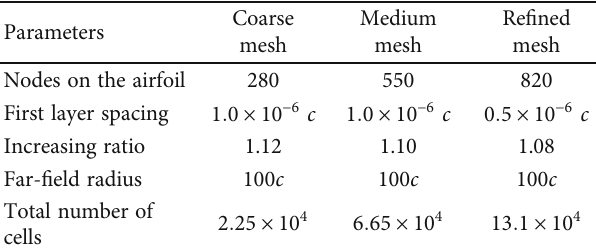
Figure 3: Planar control region used in the vorticity transport Table 1: Computational mesh parameters.